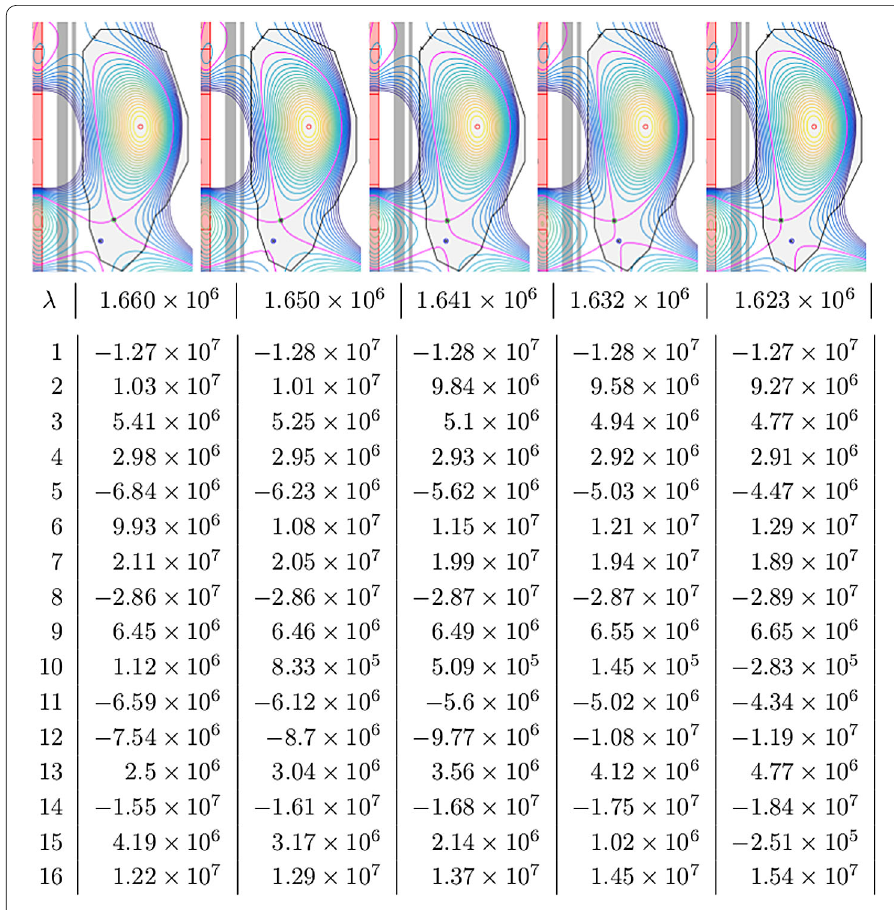
Figure 14 Results (B). The poloidal flux contour lines (top) and the 16 coil currents (bottom) in Ampère turns) for the optimal control problem (16) with objective functional C ( y ;1000, x 0 ) for x 0 = (5.02,–4.62),